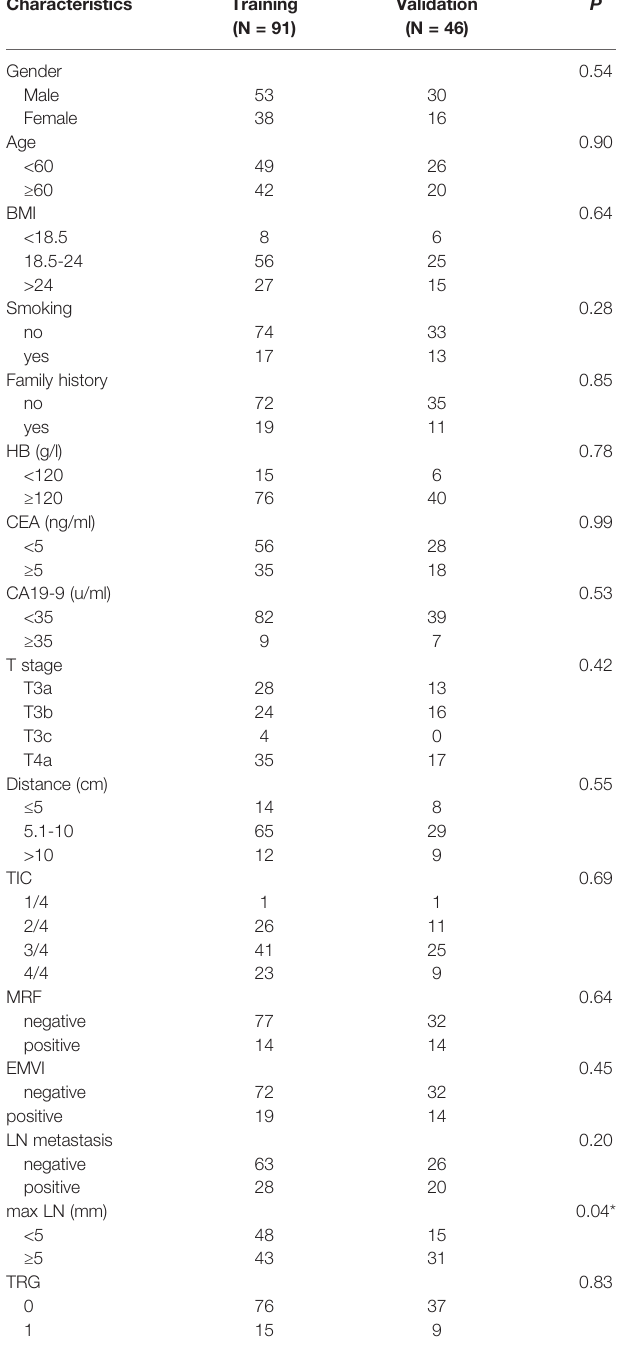
TABLE 2 | Clinical characteristics of patients in the training and validation set. Characteristics